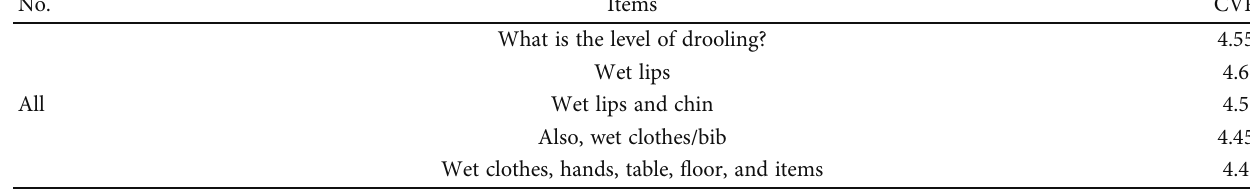
Table 2: Content validity of the Korean Drooling Infants and Preschoolers Scale (K-DRIPS). No.